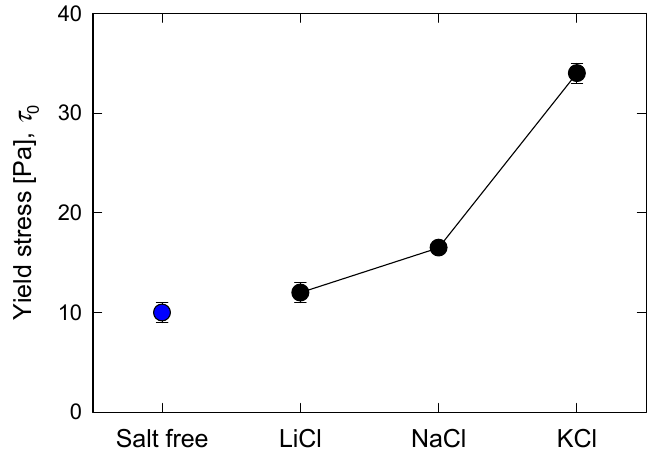
Figure 4. Effect of salt type (0.5 M) on yield stress of silica suspensions formulated at natural pH.